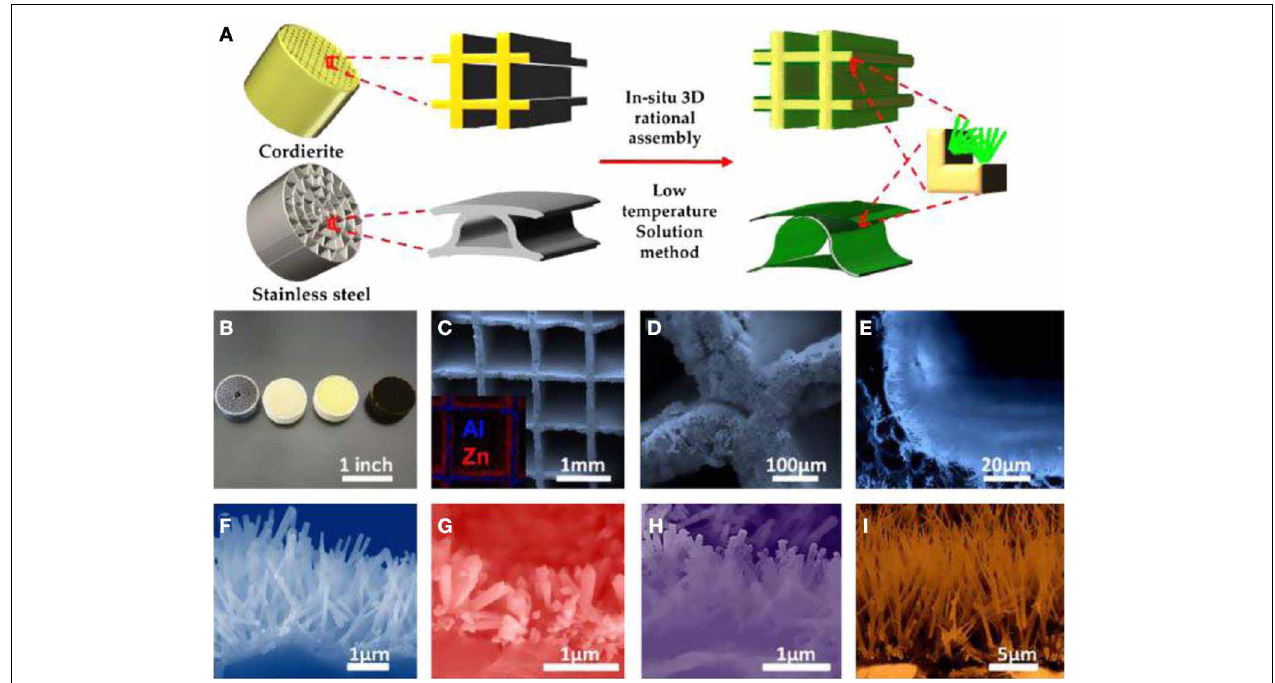
FIGURE 10 | Three-dimensional integration of various nanowires onto honeycomb substrates for a prototype high efficient catalytic converter. (A) Schematic illustration of in-situ three dimensional assembly of nanowires onto monolithic honeycomb substrates to develop a prototype catalytic converter. (B) Photographs of honeycomb substrates before and after nanostructure coverage.